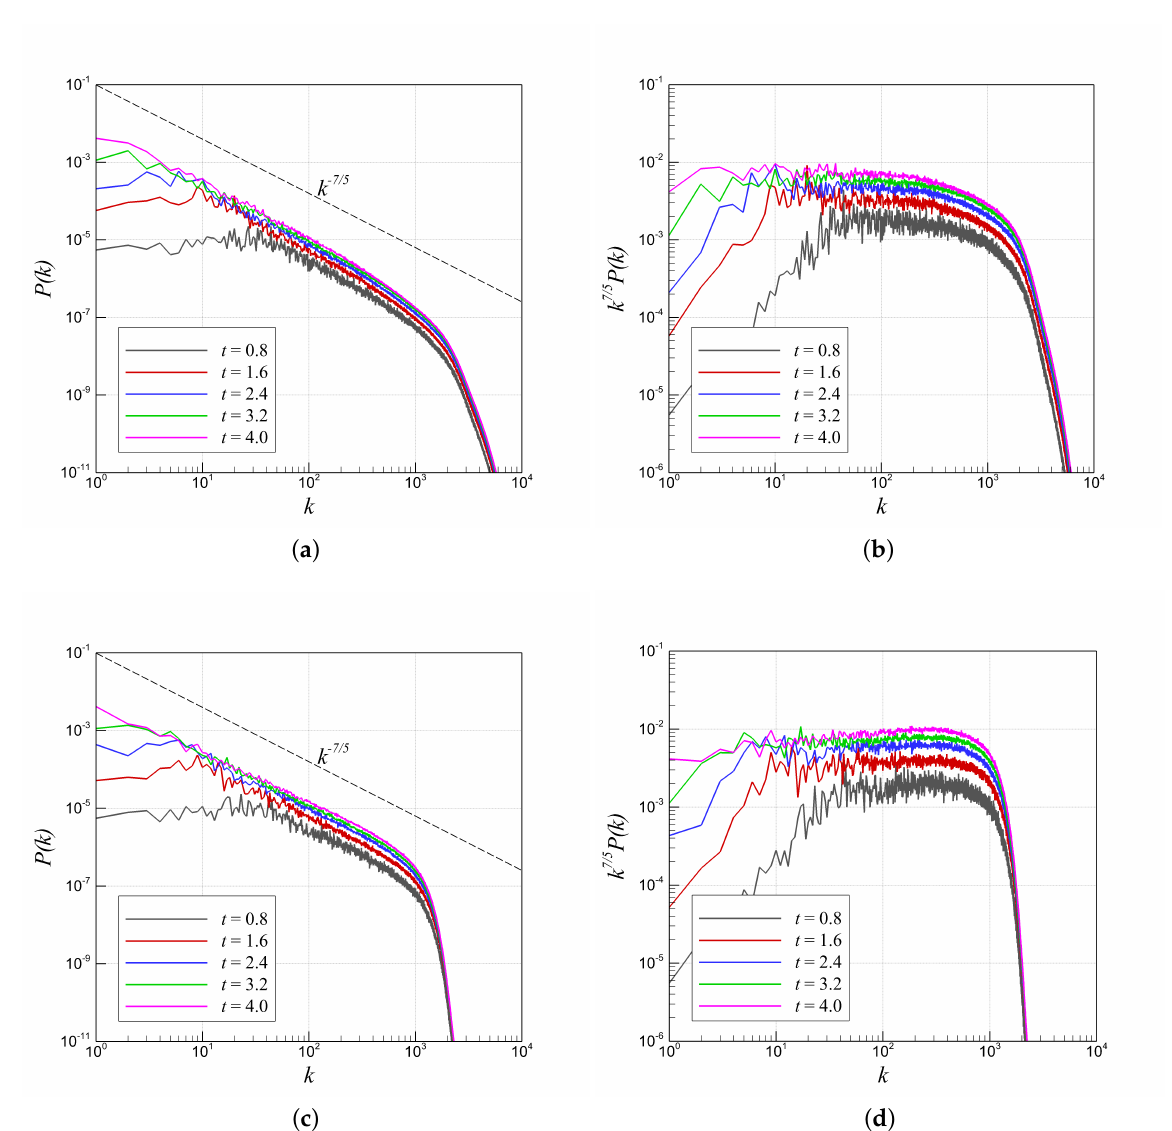
Figure 8. Time evolution of power density spectra and compensated power density spectra for the RTI problem with multi-mode perturbation obtained using different modeling approaches at a resolution of 16384 × 24576; ( a ) power density spectra using ILES-Roe solver; ( b ) compensated power density spectra using ILES-Roe solver; ( c ) power density spectra using CS+RF ( σ = 1.0) solver; ( d ) compensated power density spectra using CS+RF ( σ = 1.0)